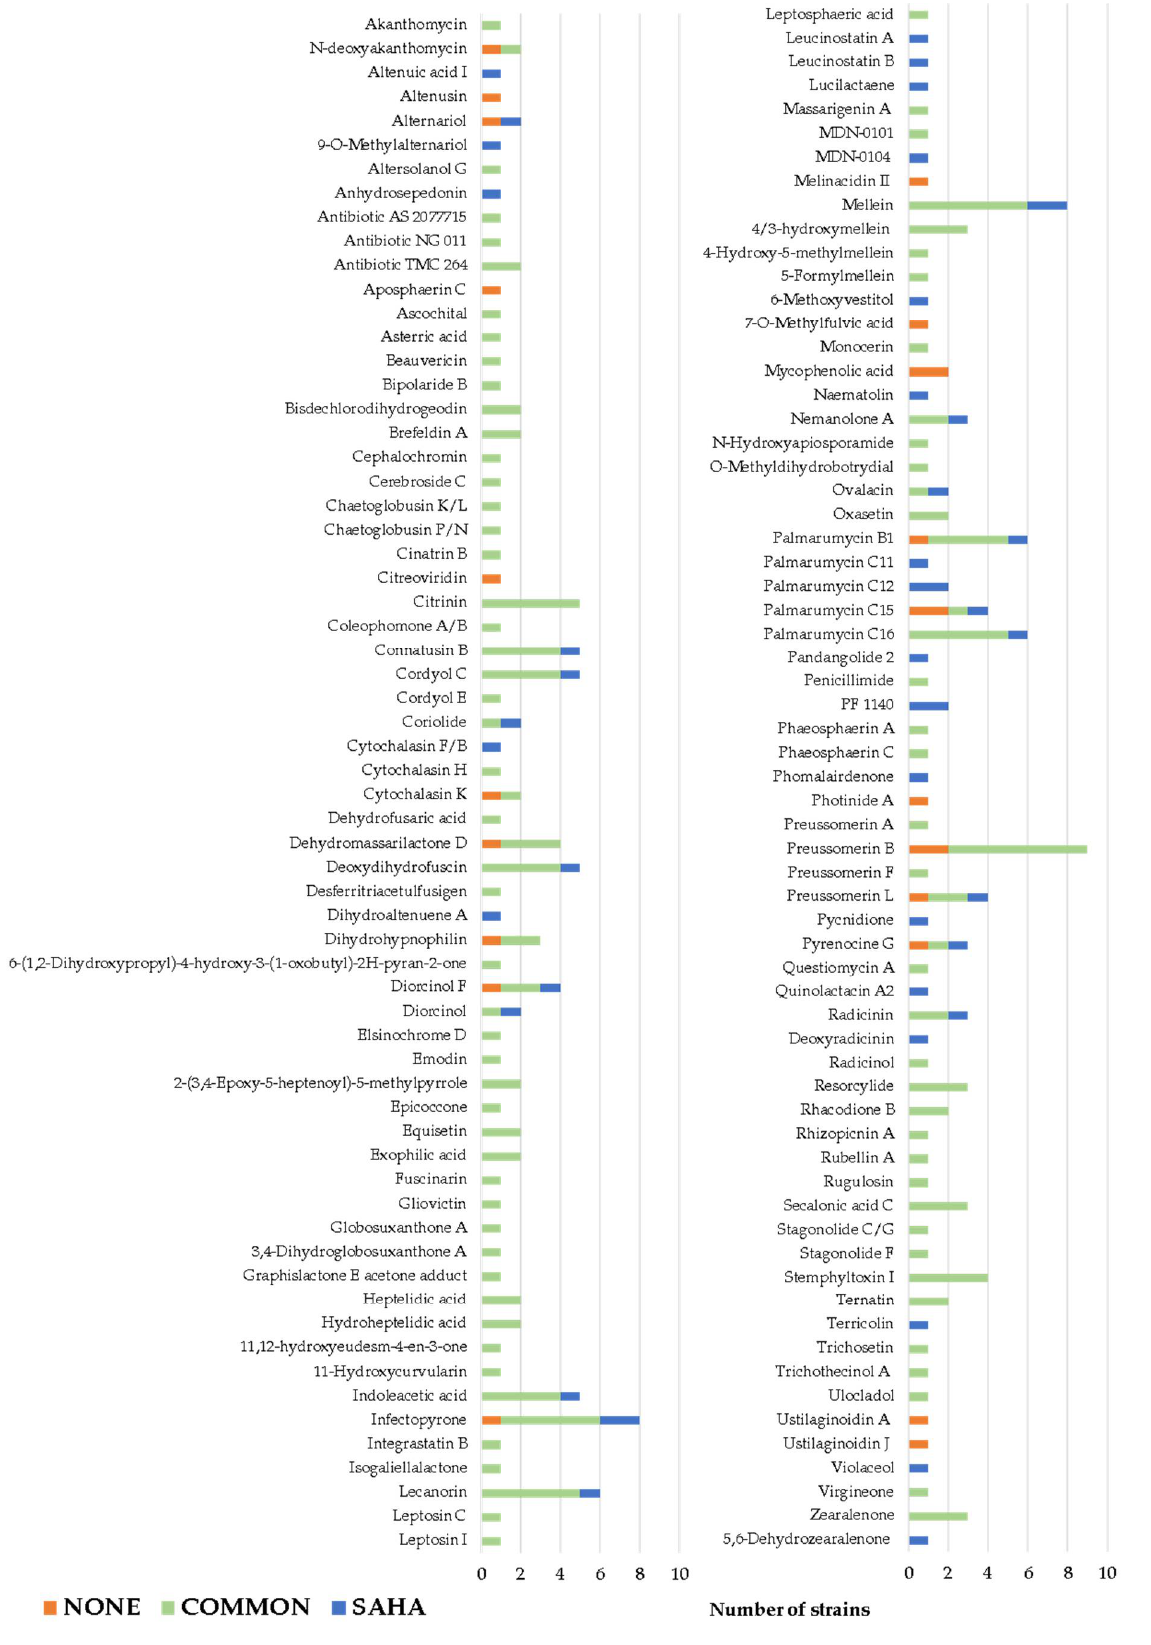
Figure 4. Distribution of known metabolites dereplicated for the leaf litter fungal population, only produced in fermentations supplemented with SAHA (blue), without SAHA (orange) and common to both conditions (green).